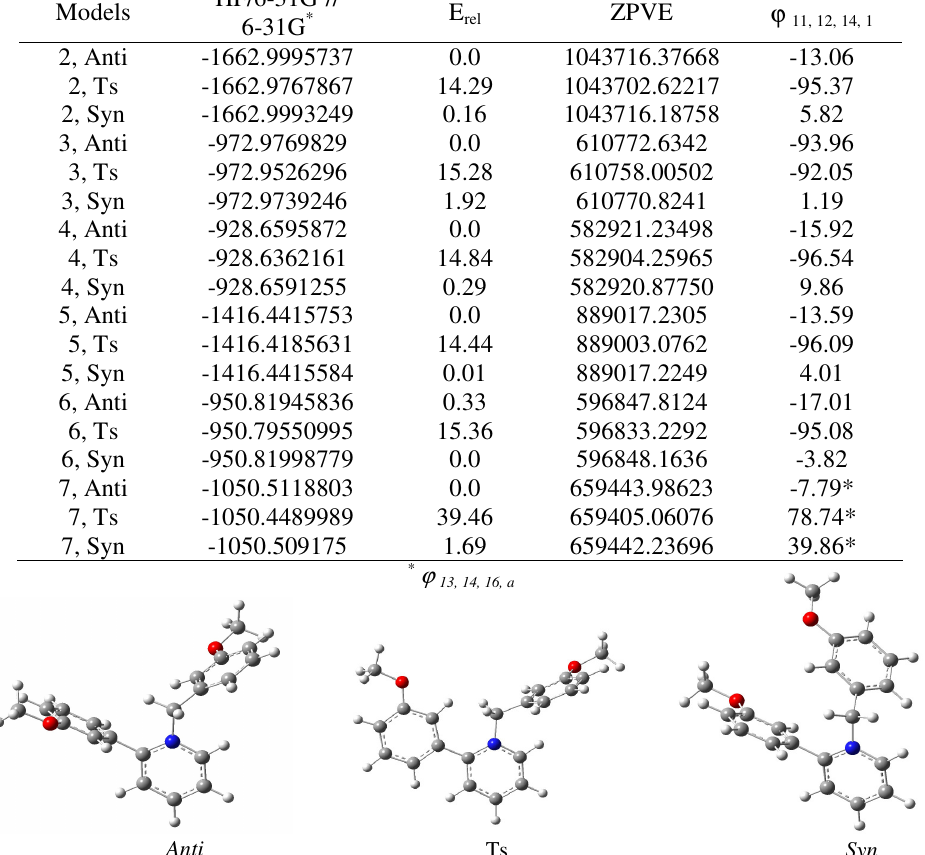
Table 4. Total and relative energies, ZPVE and ϕ Total energies and ZPVE are in Hartree, relative energies are in kcal/mol and ϕ